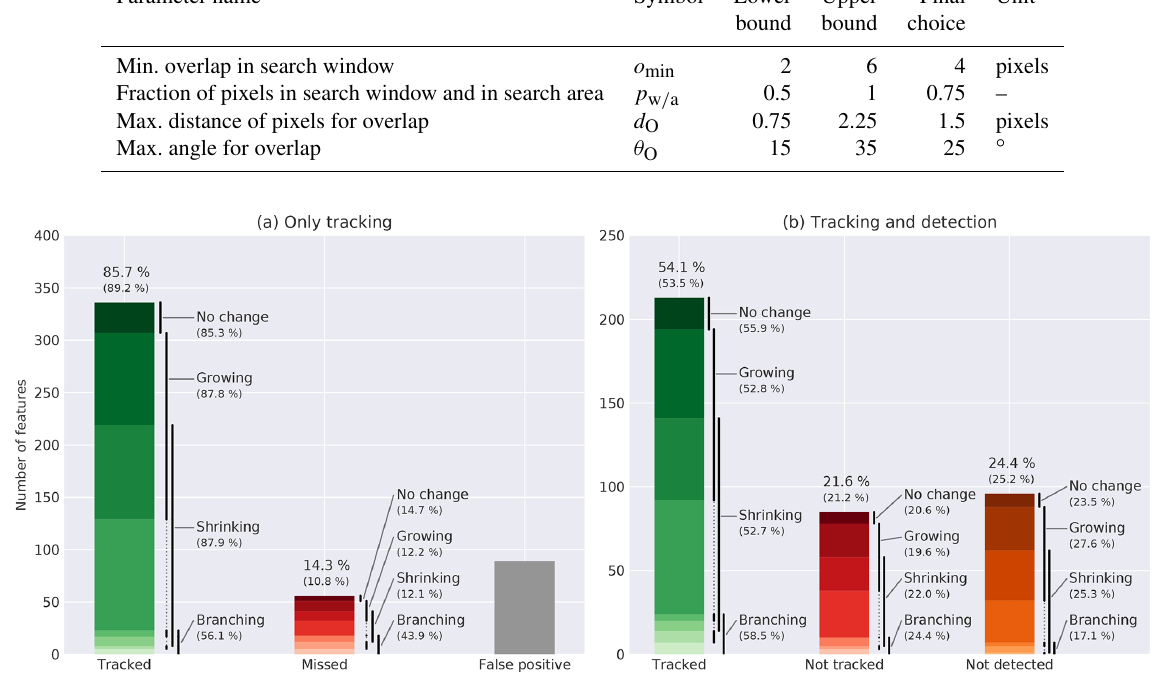
Figure 8. Evaluation of (a) only the tracking algorithm for the handpicked features and (b) a combination of the detection and tracking algorithms. The colored segments of each bar show the different combinations of changes in shape (no change, growing, shrinking, and branching) that are labeled by the black lines next to the bar. The missed tracks in panel (b) are separated into not detected or not tracked features. Above the bars the percentage compared to all handpicked tracks is given for all types and for all types except branching, which is given in